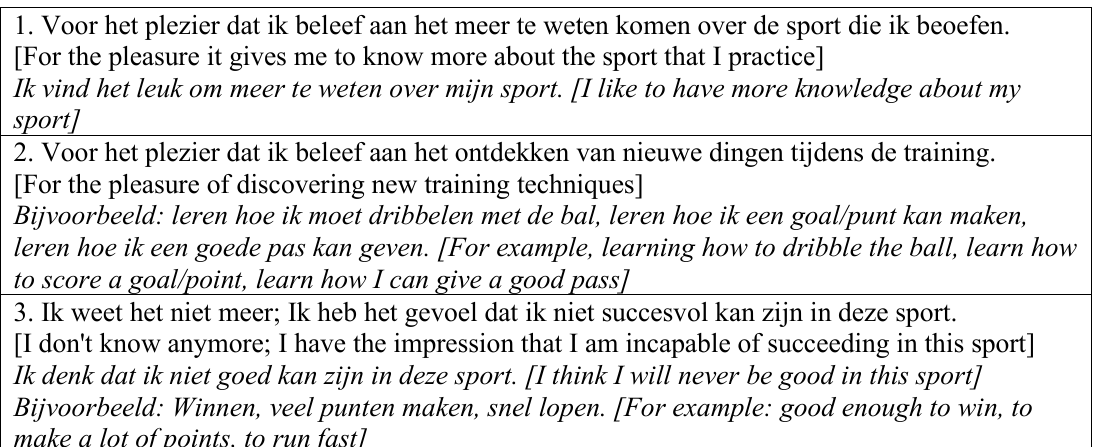
Table B1. Condensed (SMS-FL-ID-short) 14-item version of the SMS for athletes with